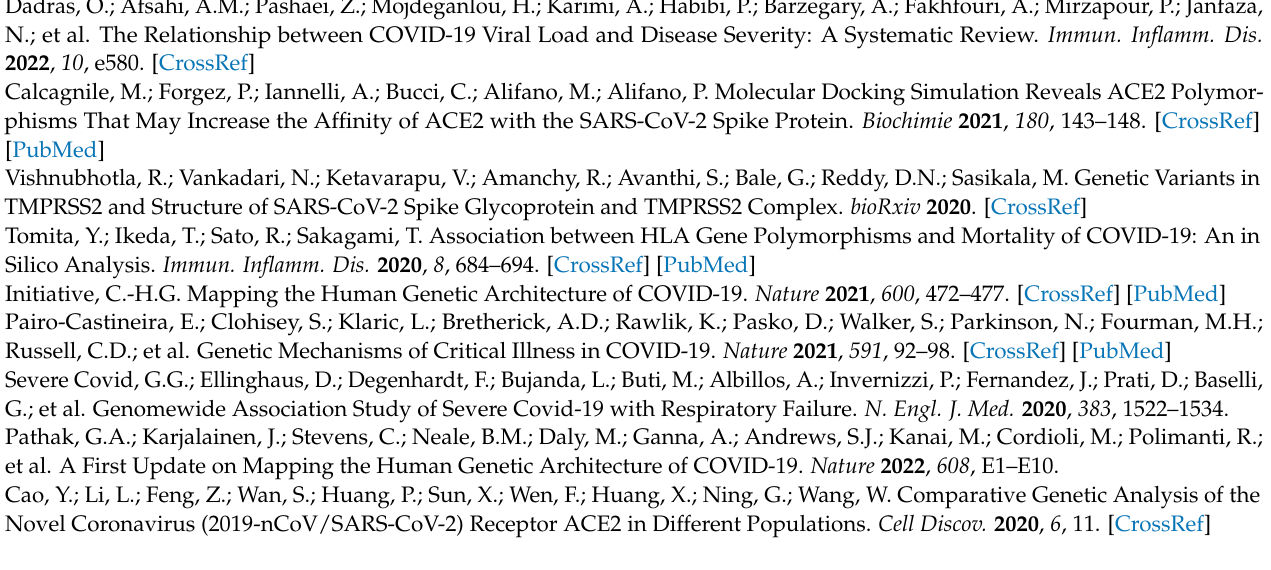
Table S3: Hardy-Weinberg equilibrium of genetic variants in the study cohort; Table S4: Comparison of ABO blood group distribution between COVID-19 patients and